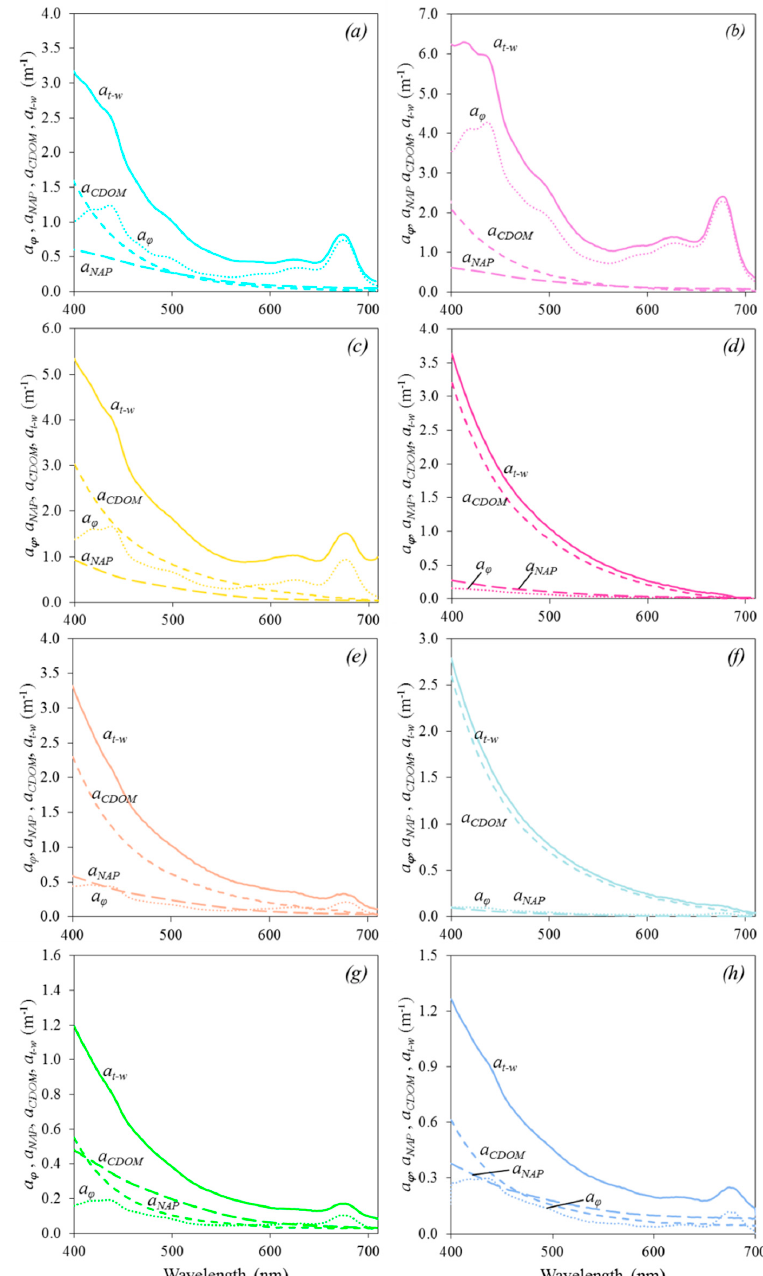
Figure 4. Average absorption coefficients by CDOM ( a cdom , high dashed line), phytoplankton ( a φ , dotted line), non-algae particles ( a nap , low dashed line), and total non-water absorption ( a t-w , continuous line) for the ( a ) BB1; ( b ) BB2; ( c ) BAR1; ( d ) BAR2; ( e ) IBI1; ( f ) IBI2; ( g ) NAV1; and ( h ) NAV2. Note the differences in the Y-axis between the surveys.